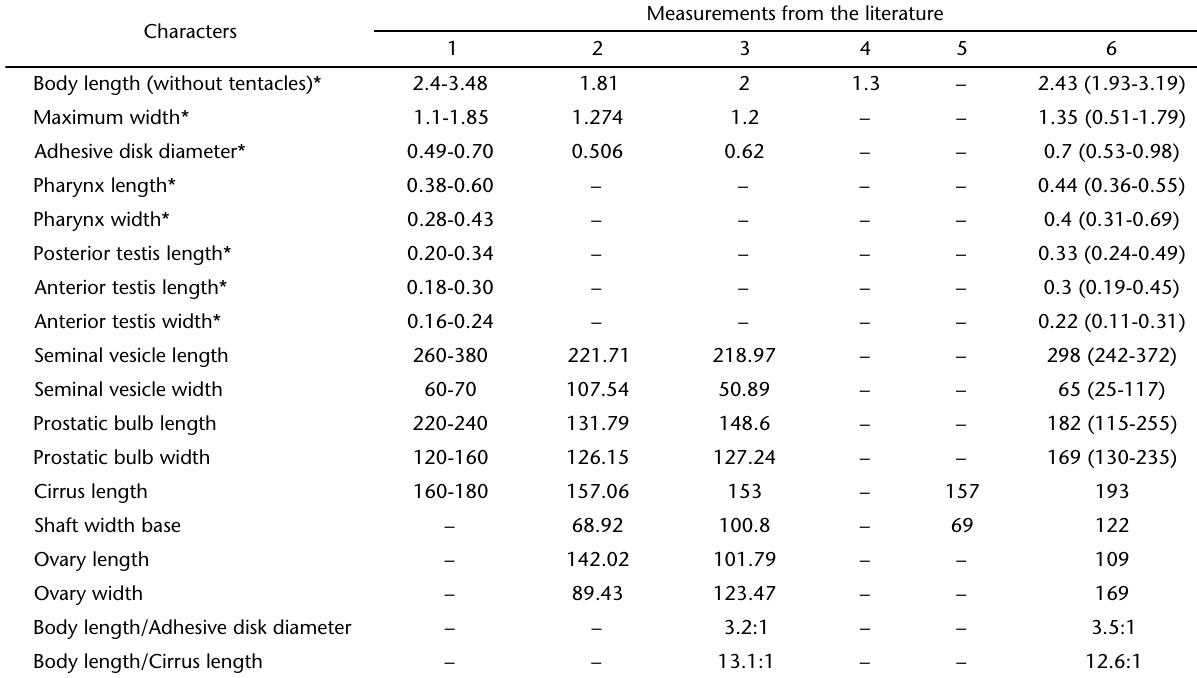
Table I. Measurements of T. iheringi from the literature and from the present work. (1) P EREIRA & C UOCOLO (1941), range; (2) D AMBORENEA (1992), # mean; (3) D AMBORENEA et al. (1997), # mean; (4) H YMAN (1955), # mean + tentacle; (5)D AMBORENEA & C ANNON (2001), # mean; (6) Present work Mean,